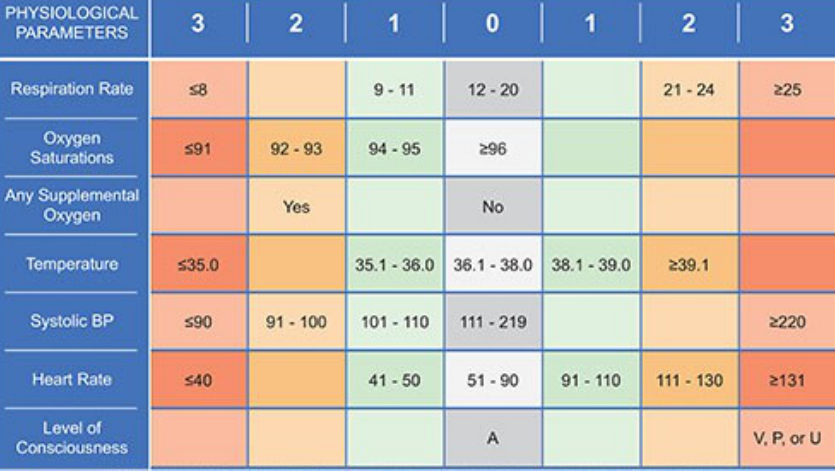
Figure 2. Form. Source: Jones [33]. The National Early Warning Score (NEWS) initiative from the Royal College of Physicians’ NEWSDIG was jointly developed and funded in collaboration with the Royal College of Physicians, Royal College of Nursing, National Outreach Forum and NHS Training for Innovation.